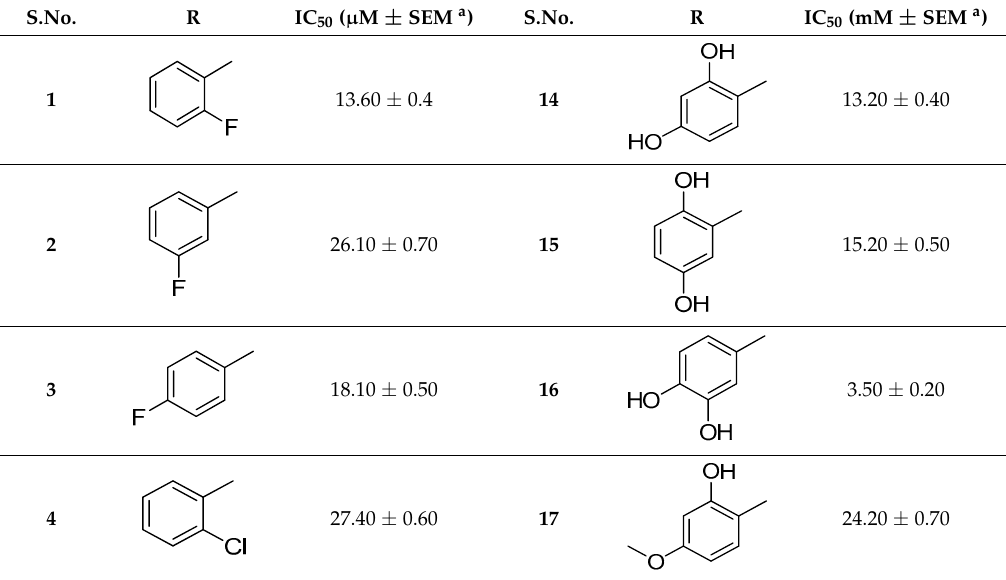
Table 1. Different substituent of quinoxaline derivatives ( 1–25 ) and their thymidine phosphorylase inhibitory activity.